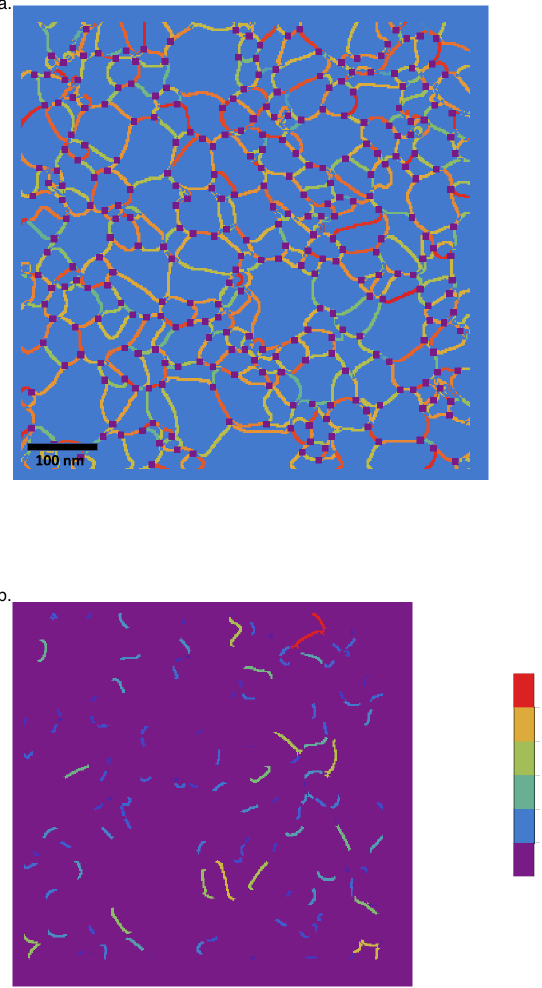
Fig. 6 A grain-boundary network with disorientations high- lighted. a The grain-boundary network with associated boundary disorientations (color coded) and triple junctions for the micro- structure shown in Fig. 1a. b The grain boundary segments with disorientations 50.0 o ≤ ϕ ≤ 60.0 o . Segments are color coded by length, with the longer segments shaded towards the red end of the color spectrum as indicated in the legend (by length in